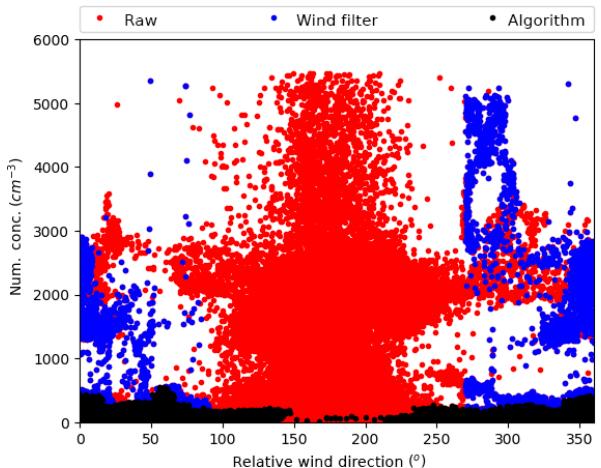
Figure 4. As in Fig. 1, but with the addition of CCN data filtered using the algorithm described in this paper. The algorithm is signif- icantly more effective than the traditional wind-based